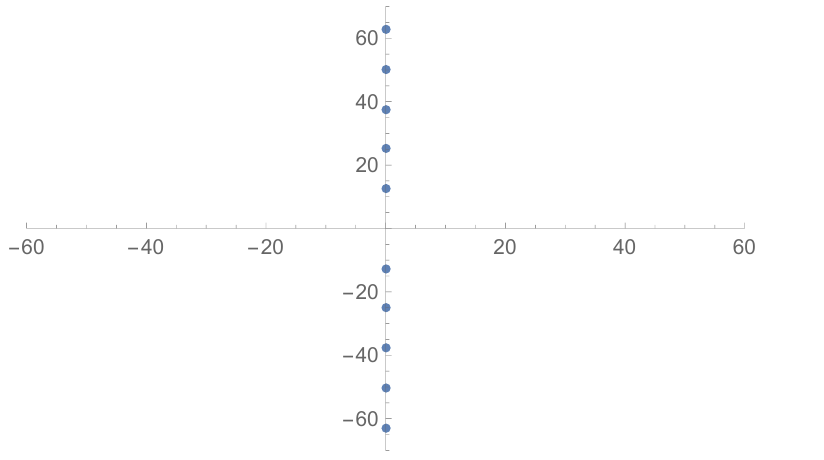
Figure 4 . The singularity structure of the Borel transform of ∆ − 1 (4.8). There are branch points at t = 4 πim , m ∈ Z